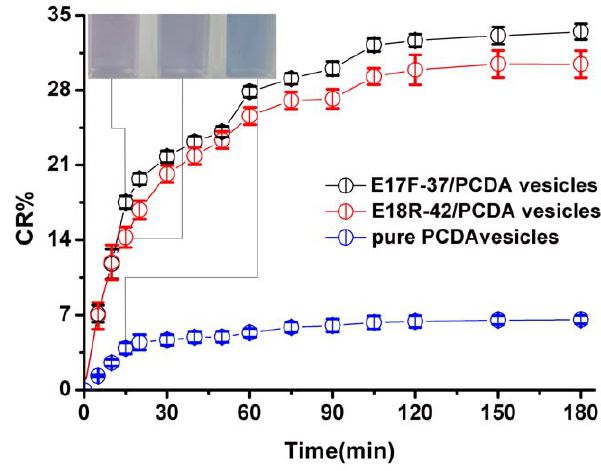
Figure 5. Kinetic study for the CR% change of E . coliO 157:H7 with E17F-37/PCDA vesicles (black curve), E18R-42/PCDA vesicles (red curve) and pure PCDA vesicles (blue curve). Inset: Visual detection in 15